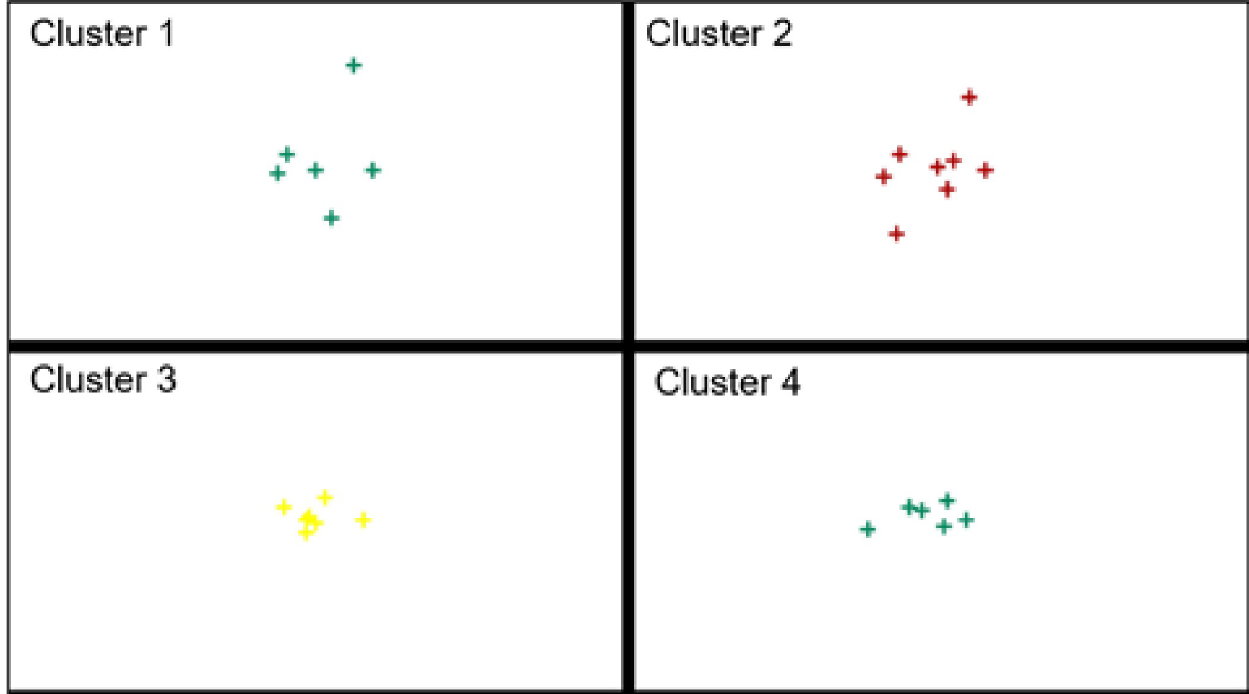
Fig 5. The topological map of similar groups of EU-27 countries for all